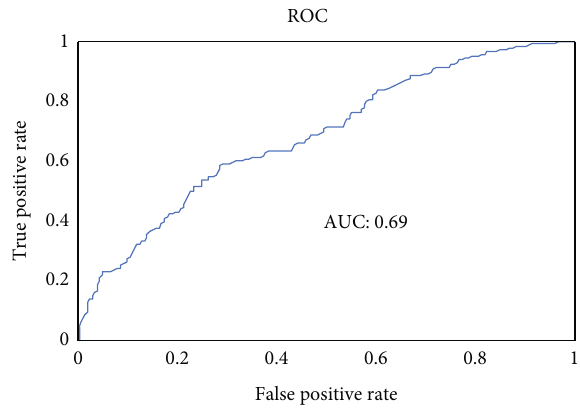
Figure 2: Receiver operating characteristic